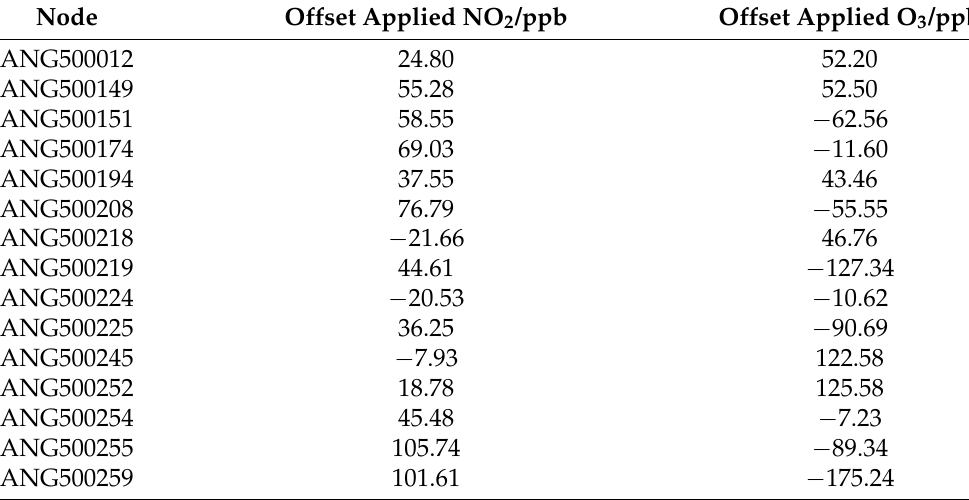
Table A3. Field offsets applied to the Laboratory calibration of the EC nodes, including the minimum and maximum offset applied for each pollutant, and the difference between